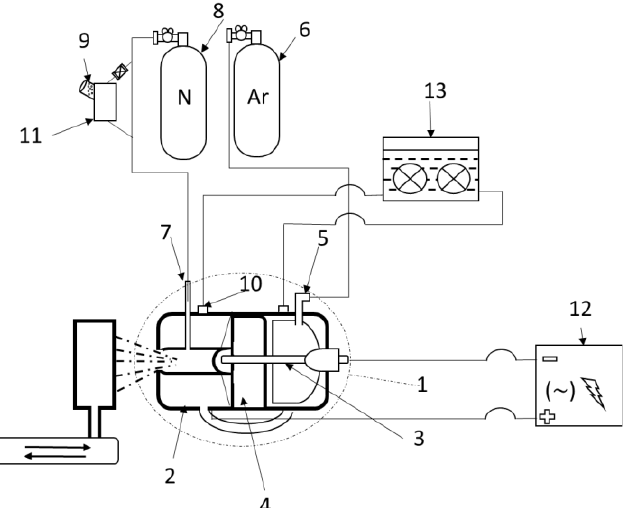
Figure 1. Schematic diagram of a powder coating setup; 1 - plasmatron, 2 - anode, 3 - cathode, 4 - interelectrode ceramic insert, 5 - tube for supplying plasma gas, 6 - argon, 7 - tube for supplying inert gas, 8 - nitrogen, 9 - sprayed powder, 10 - fittings for the inlet and outlet of the coolant, 11 - powder dispenser, 12 - power source, 13 - autonomous cooling water block.